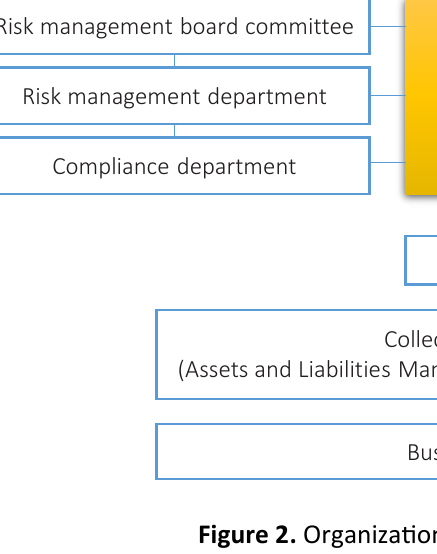
Figure 2. Organizational risk management system in the